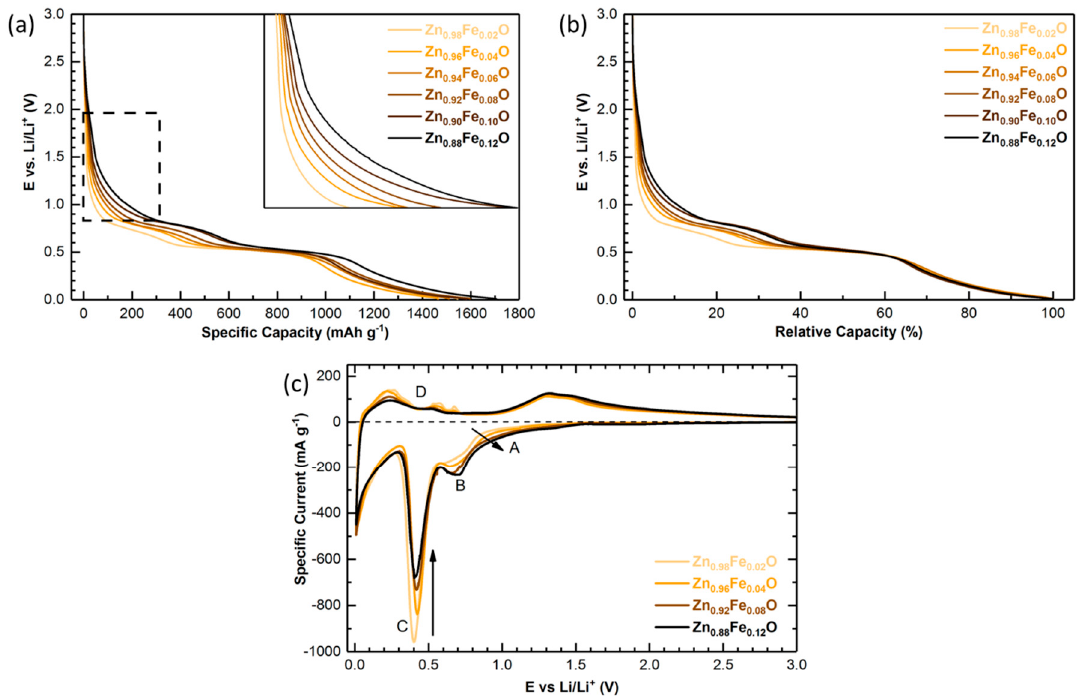
Figure 6. ( a ) Potential profiles for the first galvanostatic discharge of Zn 1 − x Fe x O-based electrodes (x = 0.02, 0.04, 0.06, 0.08, 0.10, and 0.12), applying a discharge rate of 0.05C (i.e., 48.3 mA g − 1 ); the inset shows a magnification of the area highlighted by the dashed box; ( b ) The same potential profiles as presented in ( a ), but plotted versus the normalized capacity; ( c ) Cyclic voltammetry conducted for selected samples (x = 0.02, 0.04, 0.08, and 0.12), applying a sweeping rate of 50 µV s − 1 .